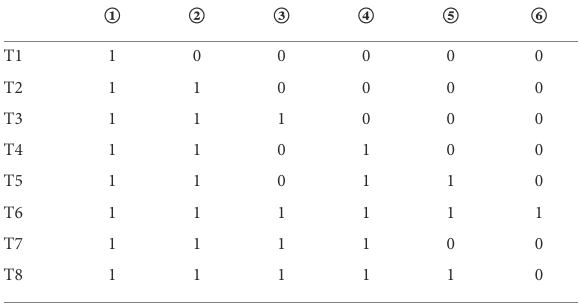
TABLE 2 Preliminary Q-matrix of data analysis ability.